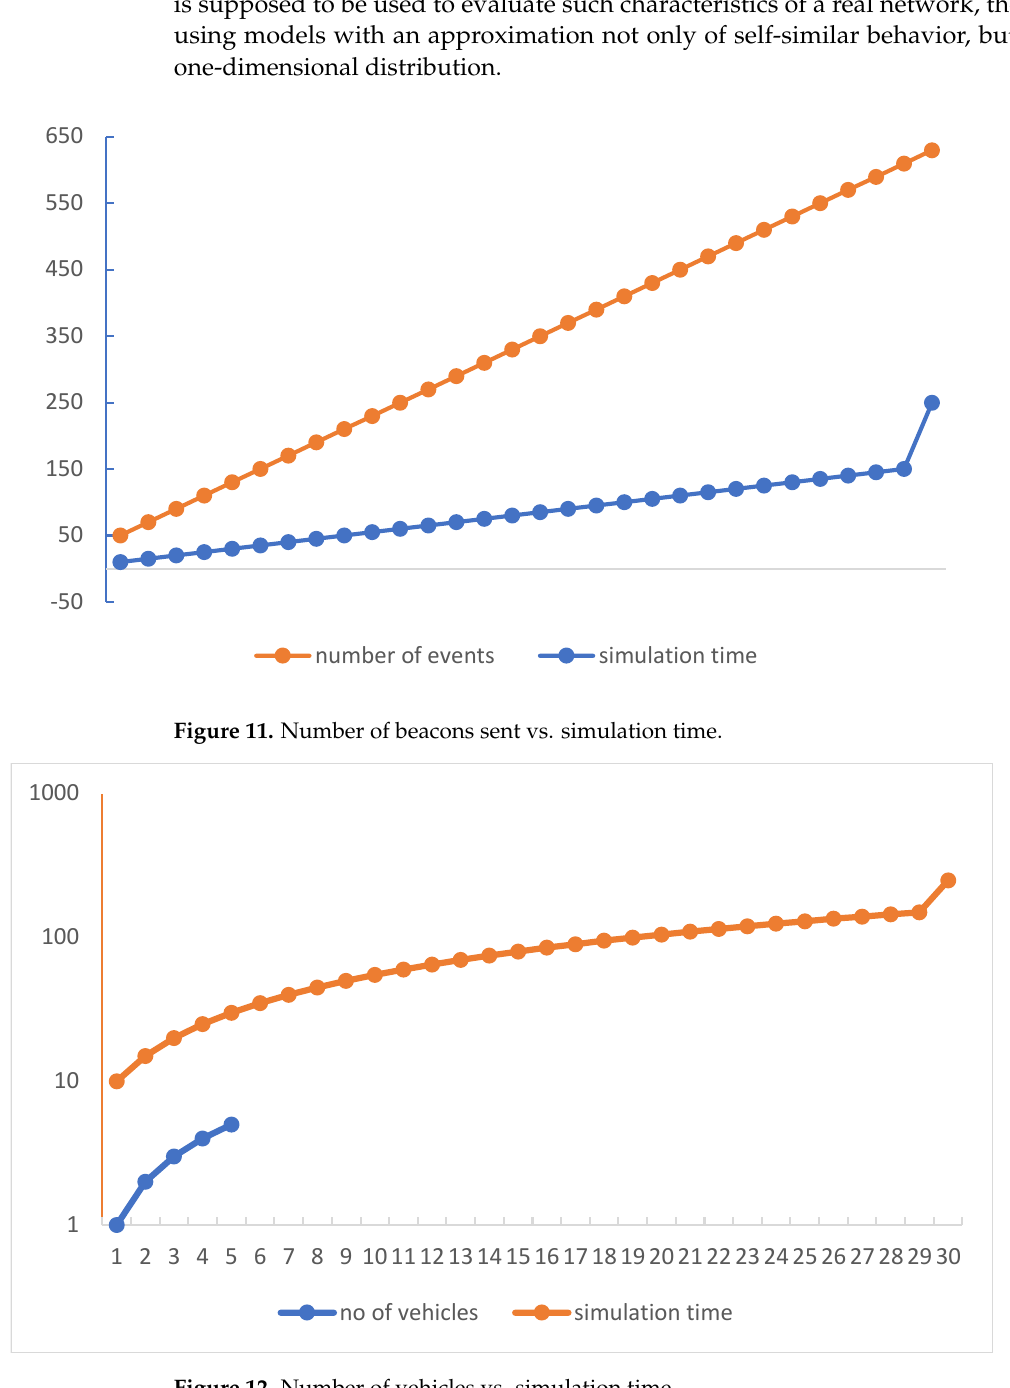
Figure 12. Number of vehicles vs. simulation